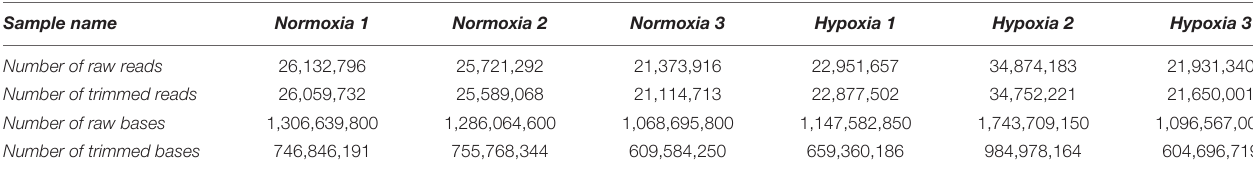
FIGURE 1 | Hypoxia exposure has no effect on the hatchability and viability of medaka embryos. (A) Embryo hatchability was assessed continuously for 28 days after normoxia or hypoxia exposure. (B) Total embryo viability was determined at day 28 after normoxia or hypoxia exposure. n.s. represents not statistically significant ( p > 0.05). TABLE 1 | Statistics for small RNA